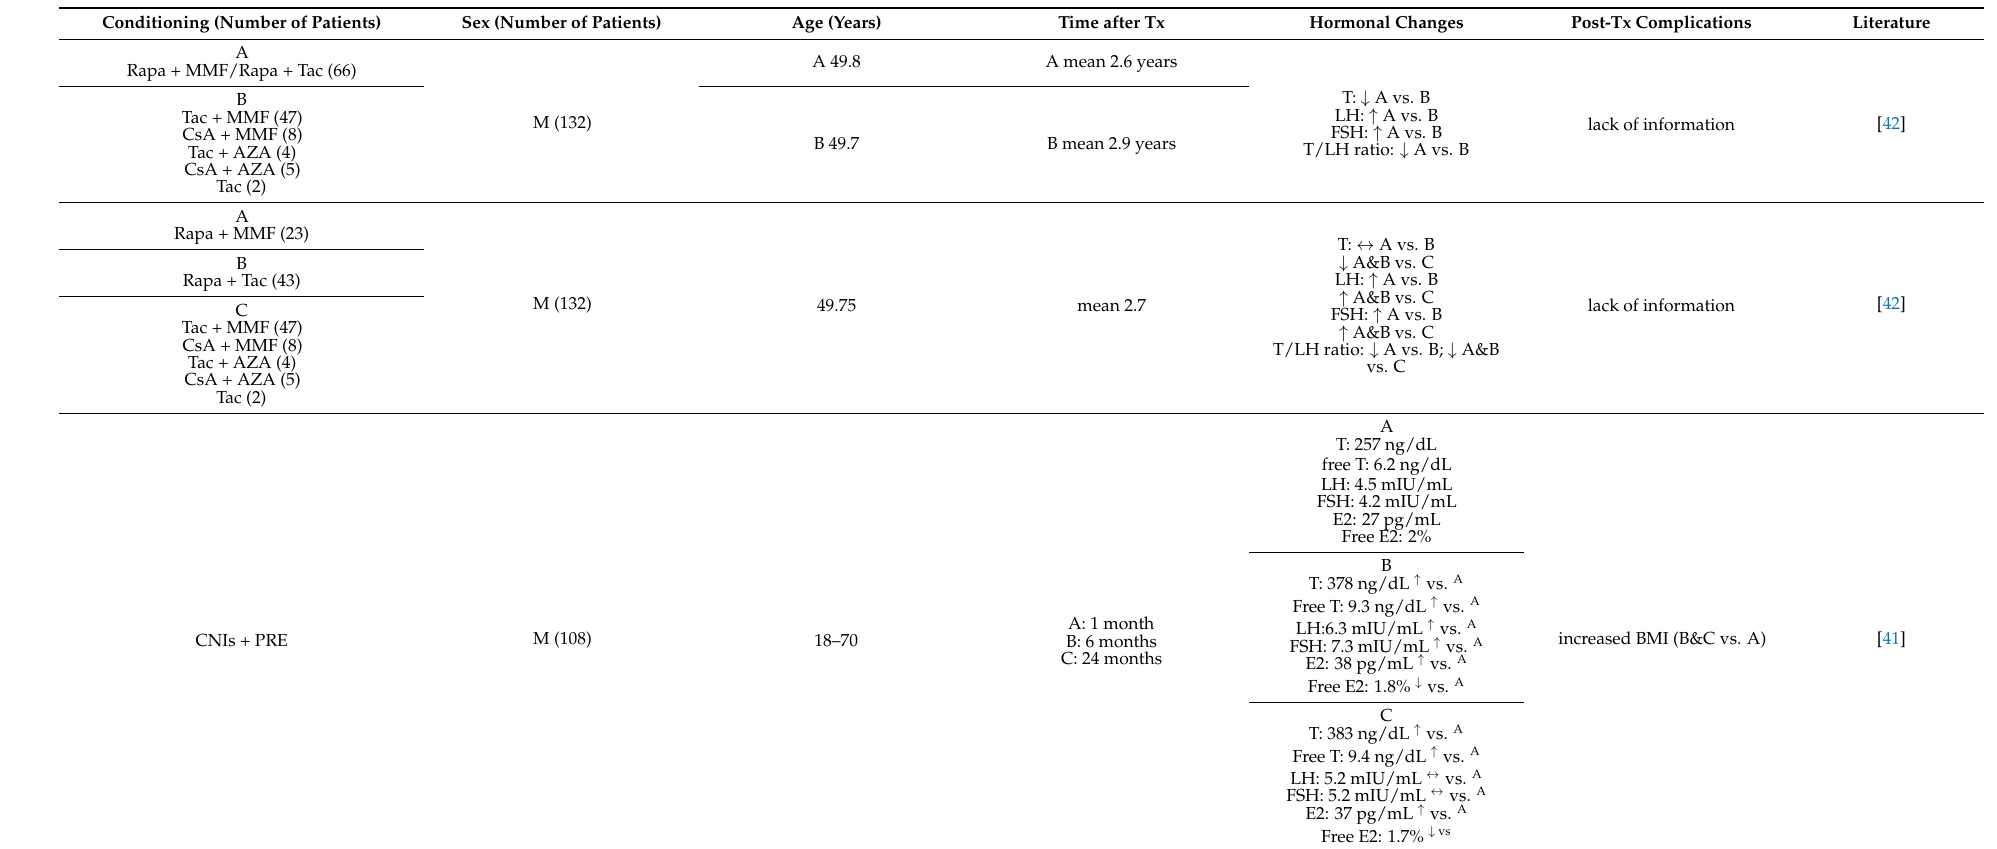
Table 4. Demographical and medical data of cardiac transplant